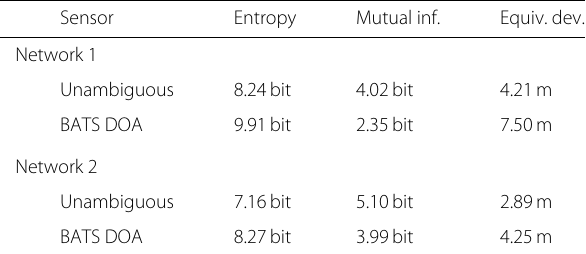
Table 4 Entropy and mutual information of different DOA networks Sensor Entropy Mutual inf. Equiv. dev.